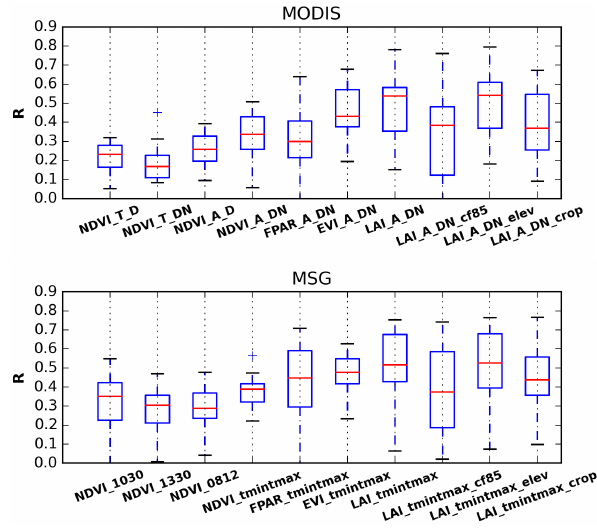
Figure 3. Sensitivity analyses of VTCI to different variables. The box plots show the R values of the comparisons between in situ soil moisture measurements and VTCI calculated from different con- figurations (Table 3) for all stations. The results for MODIS and SEVIRI are shown